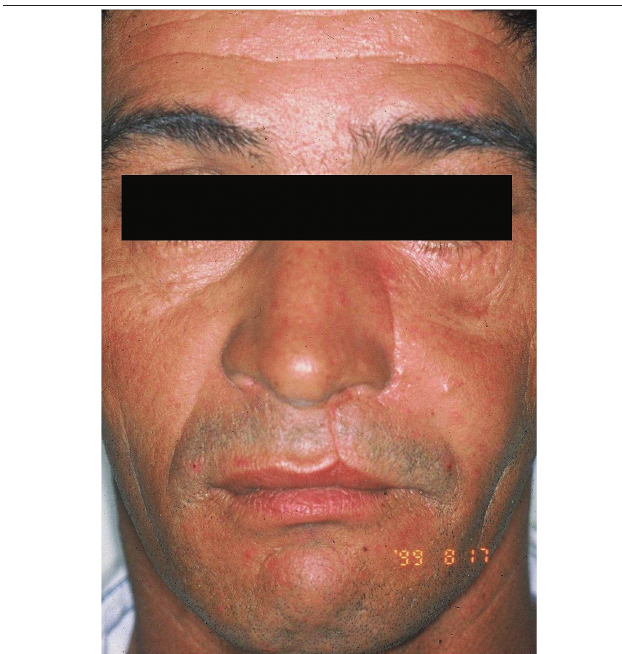
figurE 6 − Extraoral view during follow-up